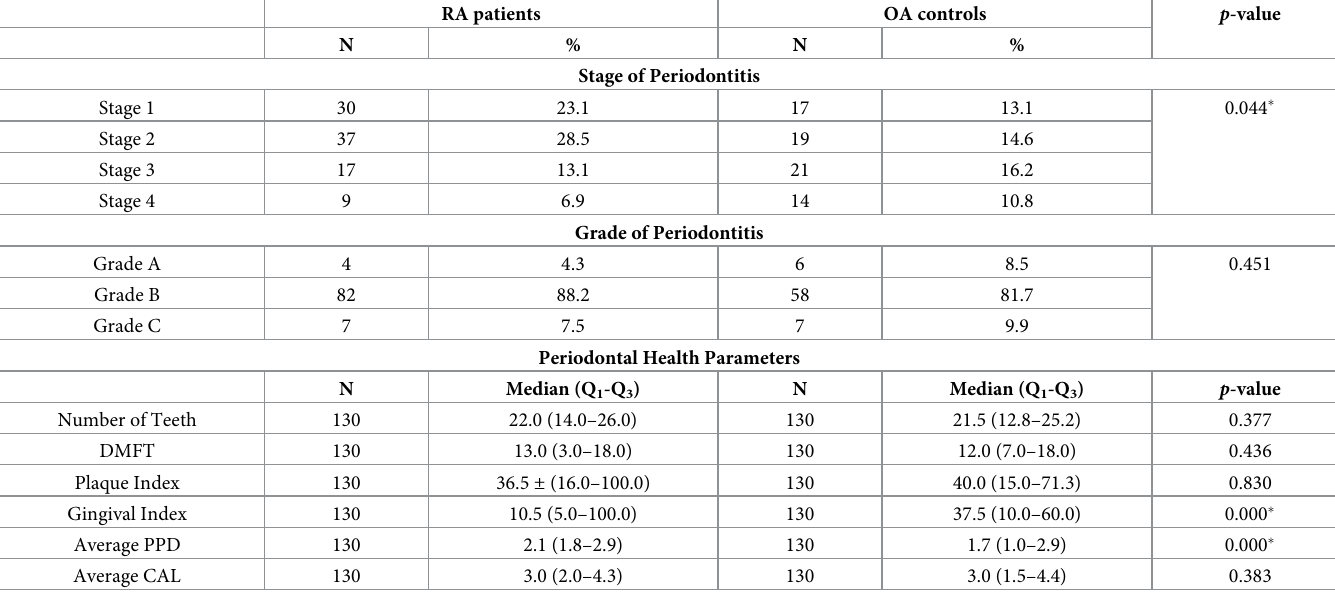
Table 2. Stage and grade of periodontitis and periodontal health parameters in cases and controls.